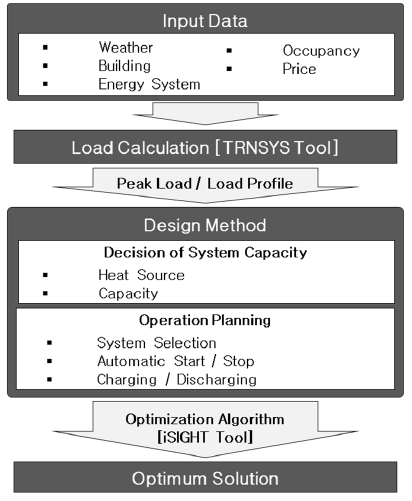
Figure 2. Optimization process of thermal storage system.